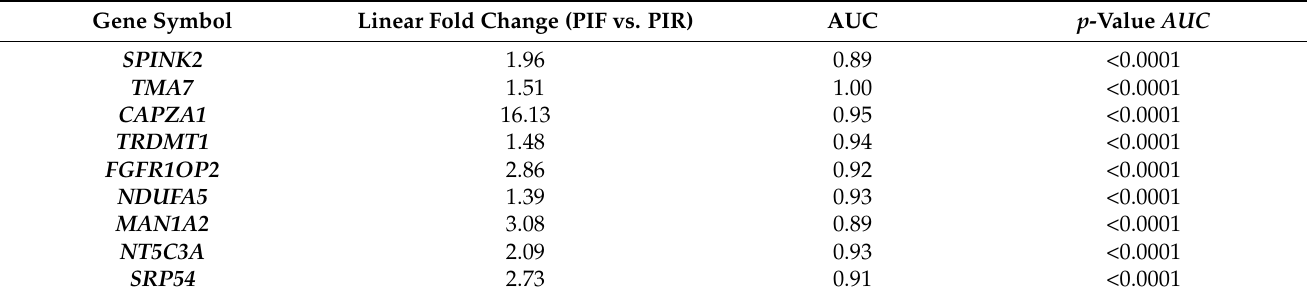
Table 1. Linear Fold Changes between PIF and PIR patients were calculated using HTA 2.0 data in local cohort. Areas under Curve (AUC) and relative p -values were calculated using TARGET data. TRDMT1 and NDUFA5 (indicated in grey letters) were not further analyzed owing to low RMA values